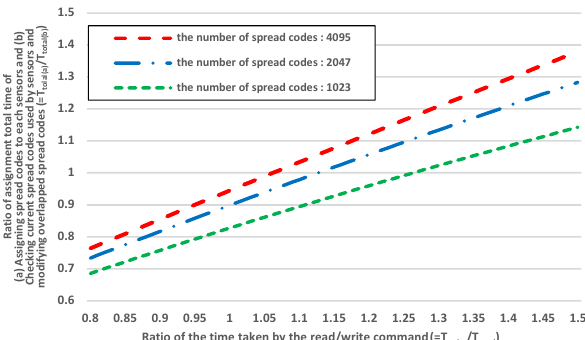
Figure 7. Relationship between the ratio of read/write command time and the ratio of total assignment time for (a) assigning spread codes to each sensor and (b) checking current spread codes used by sensors and modifying overlapped spread